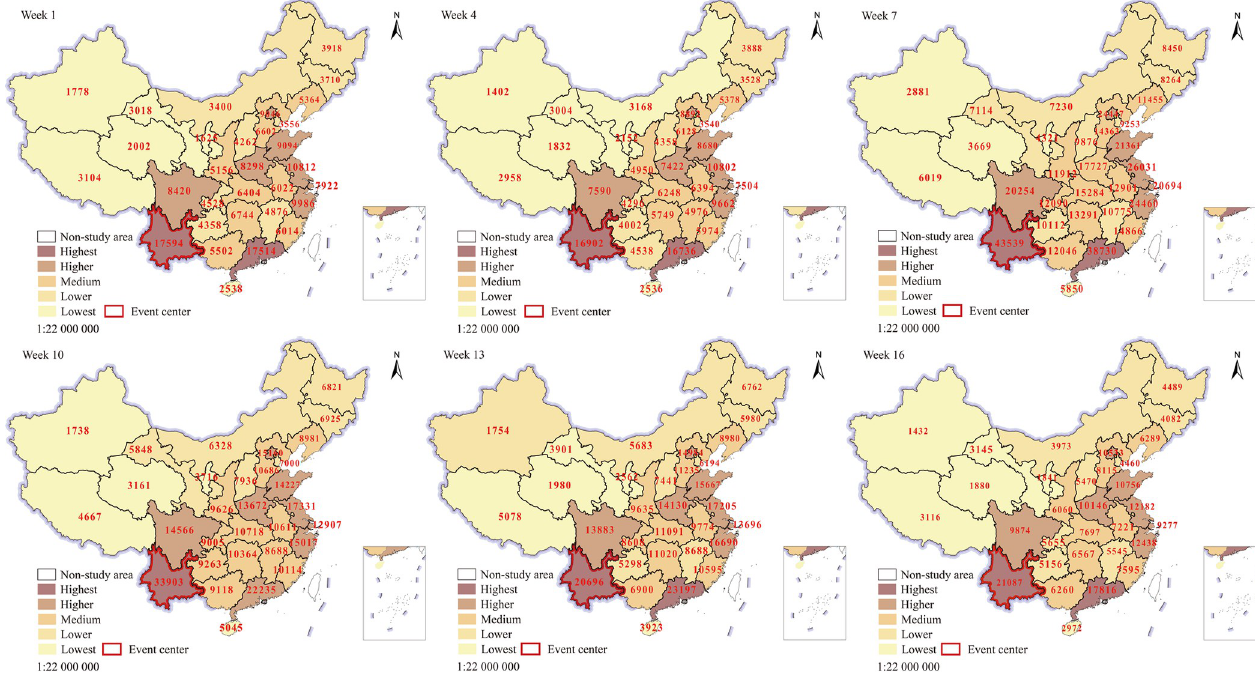
Fig 2. Spatial representation of internet attention in 31 provinces (municipalities directly under the Central Government and autonomous regions). The underlying layer is quoted from the Sky Map website (https://www.tianditu.gov.cn/), the standard map review number is GS (2019) 1833.